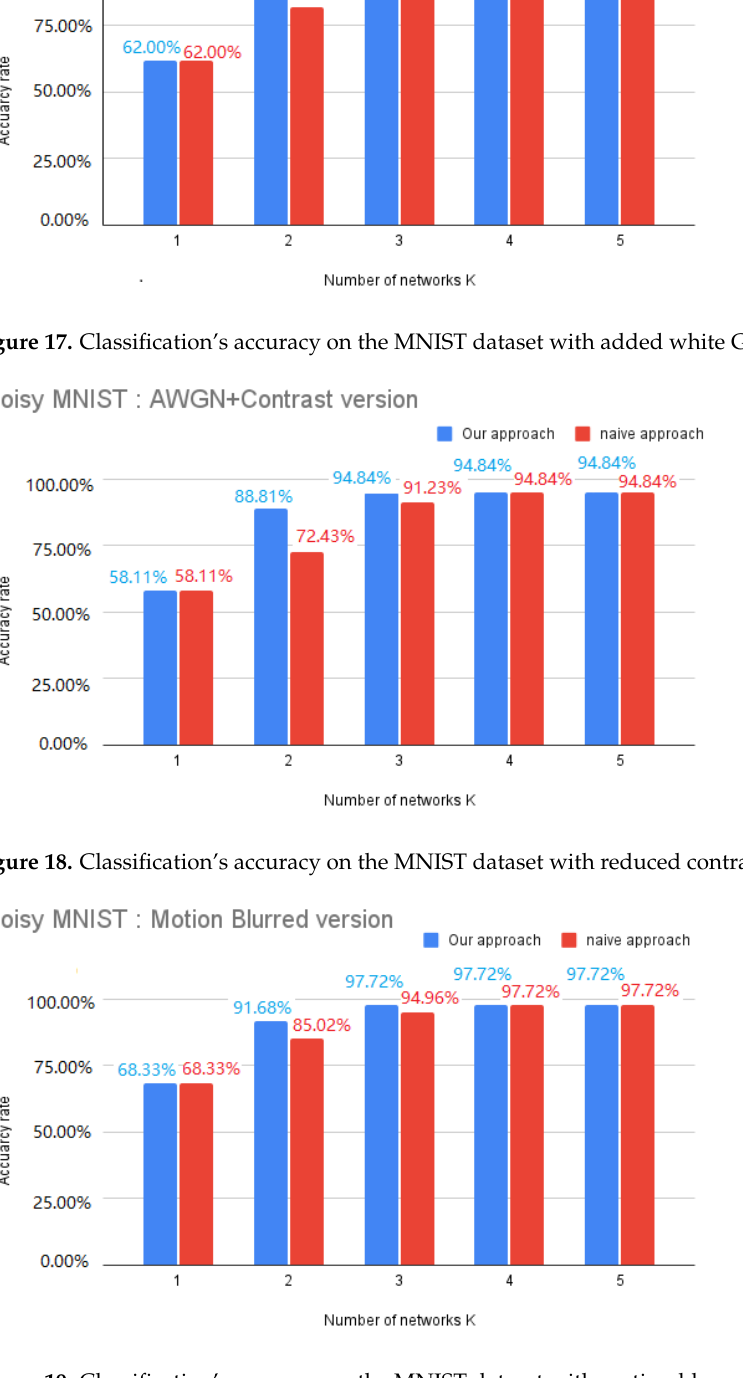
Figure 19. Classification’s accuracy on the MNIST dataset with motion-blurred